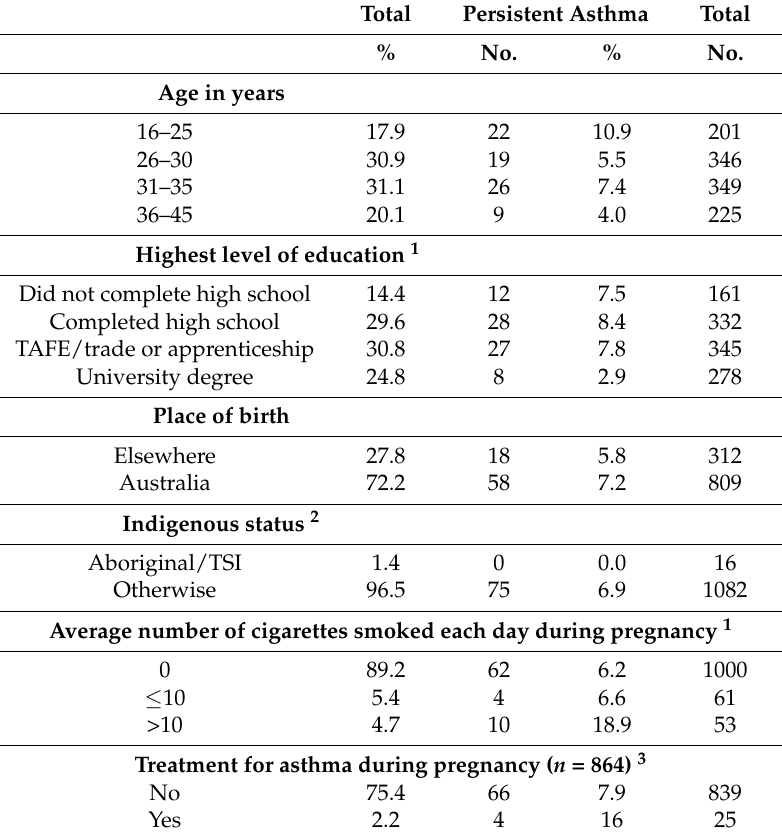
Table 2. Characteristics of mothers: overall and those with children with persistent asthma at end of